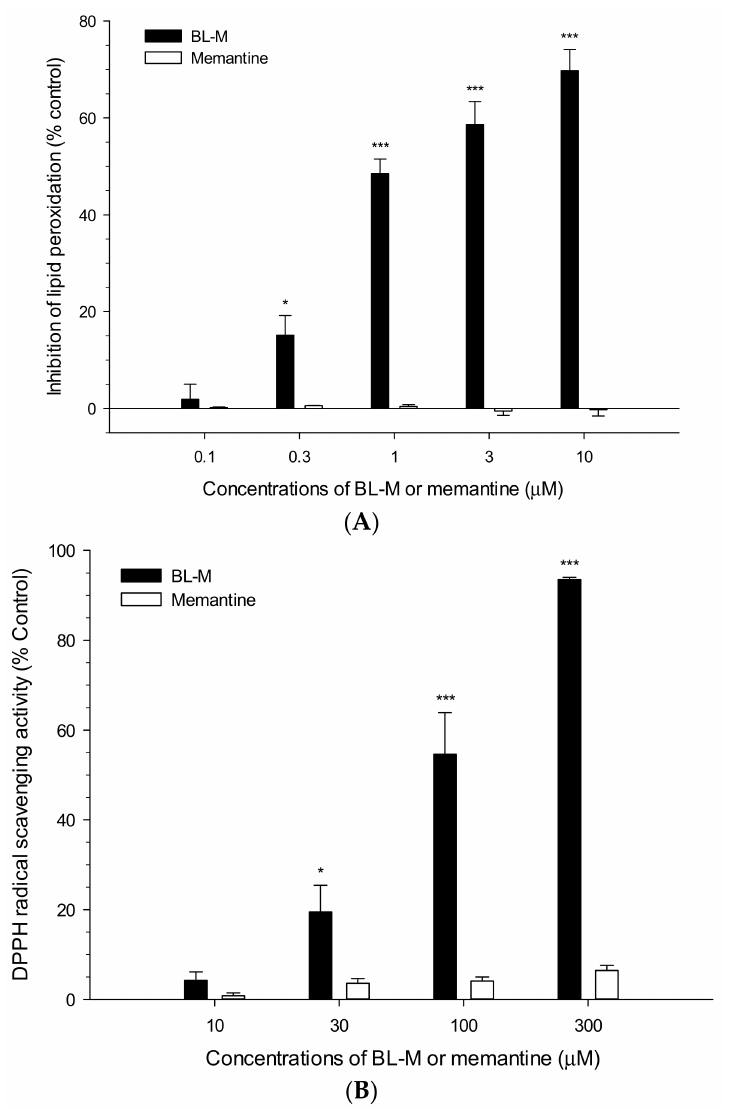
Figure 4. Differential antioxidant activities of BL-M and memantine. Lipid peroxidation induced by Fe 2+ and L -ascorbic acid in rat brain homogenates ( A ) and DPPH radical scavenging activities ( B ) were assessed in the absence or presence of BL-M or memantine, as described in the Section 4 (* p < 0.05, *** p < 0.001 vs. control). Each data represents the mean ± S.E.M. from at least three independent